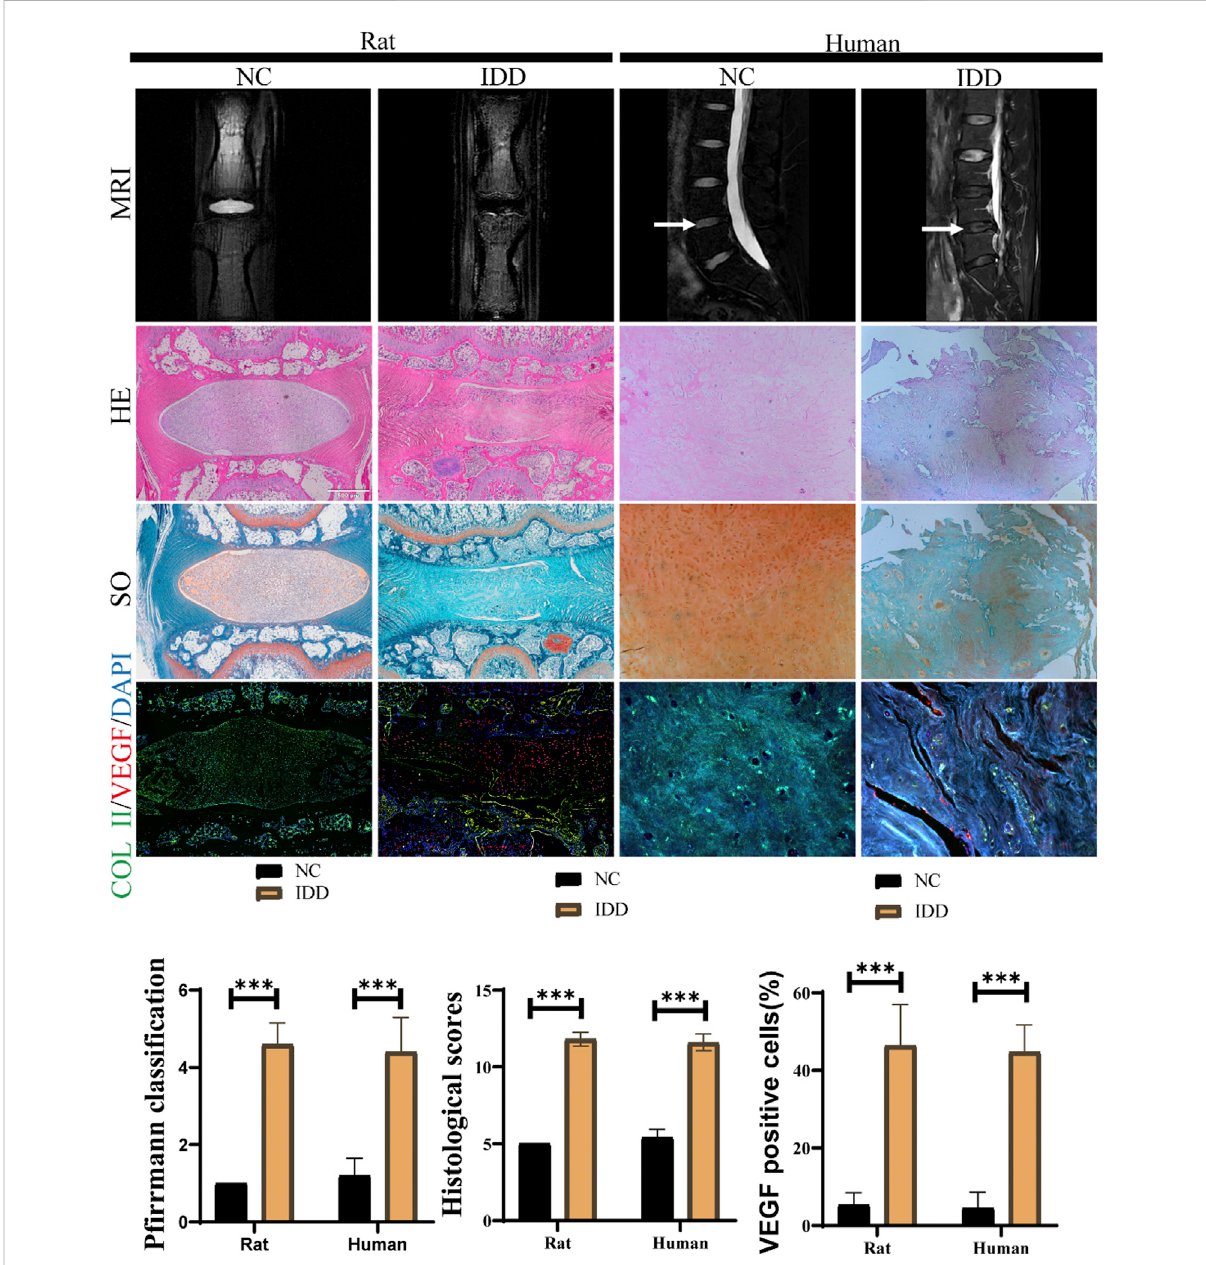
FIGURE 1 Aberrant VEGF expression in IVDs in rats and humans. (A) MRI, H&E staining, SO staining for observation of disc degeneration, and immuno fl uorescent staining for measurement of VEGF (red) and COL II (green) expression in human and rat IVDs. (B,C) The histological scores and MRIgradingscoresinhumanandratIVDs. (D) RatioofVEGFpositiveNPcellnumberstototalNPcellsinIVDsofhumanandrat.dataareexpressedas mean ± SD (n = 5). * p < 0.05; *** p < 0.01. Scale bar = 500